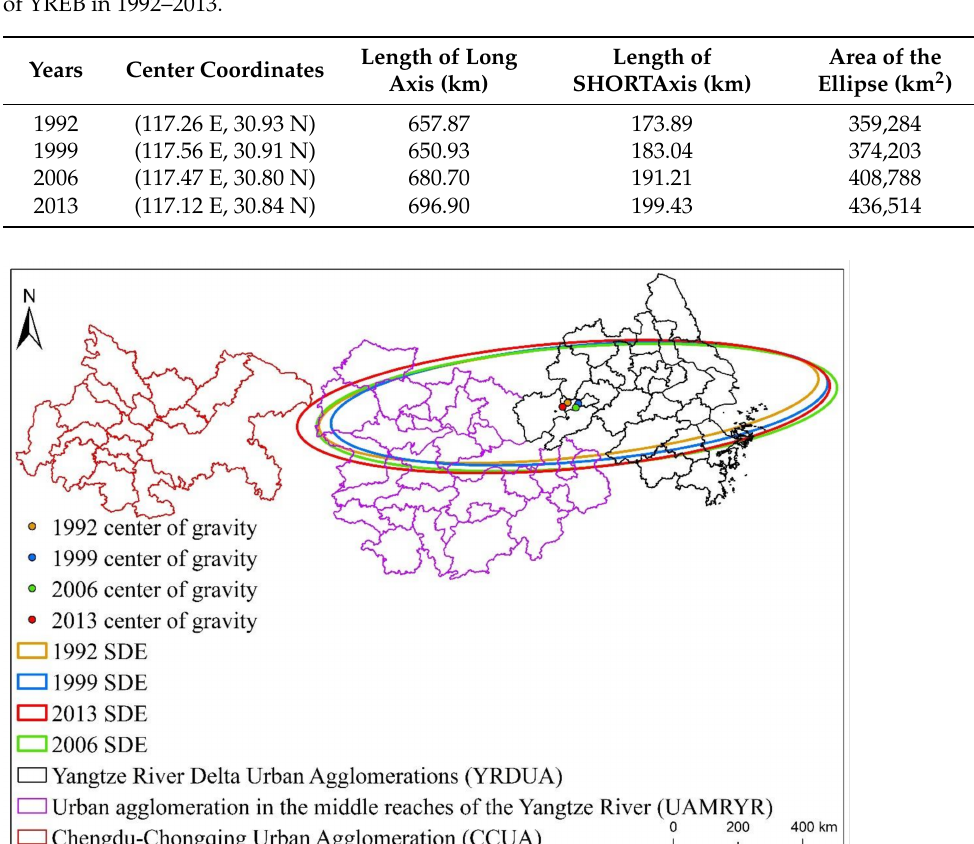
Figure 12. EPC standard deviation ellipse and average center of gravity distribution of the three major urban agglomerations of YREB from 1992 to